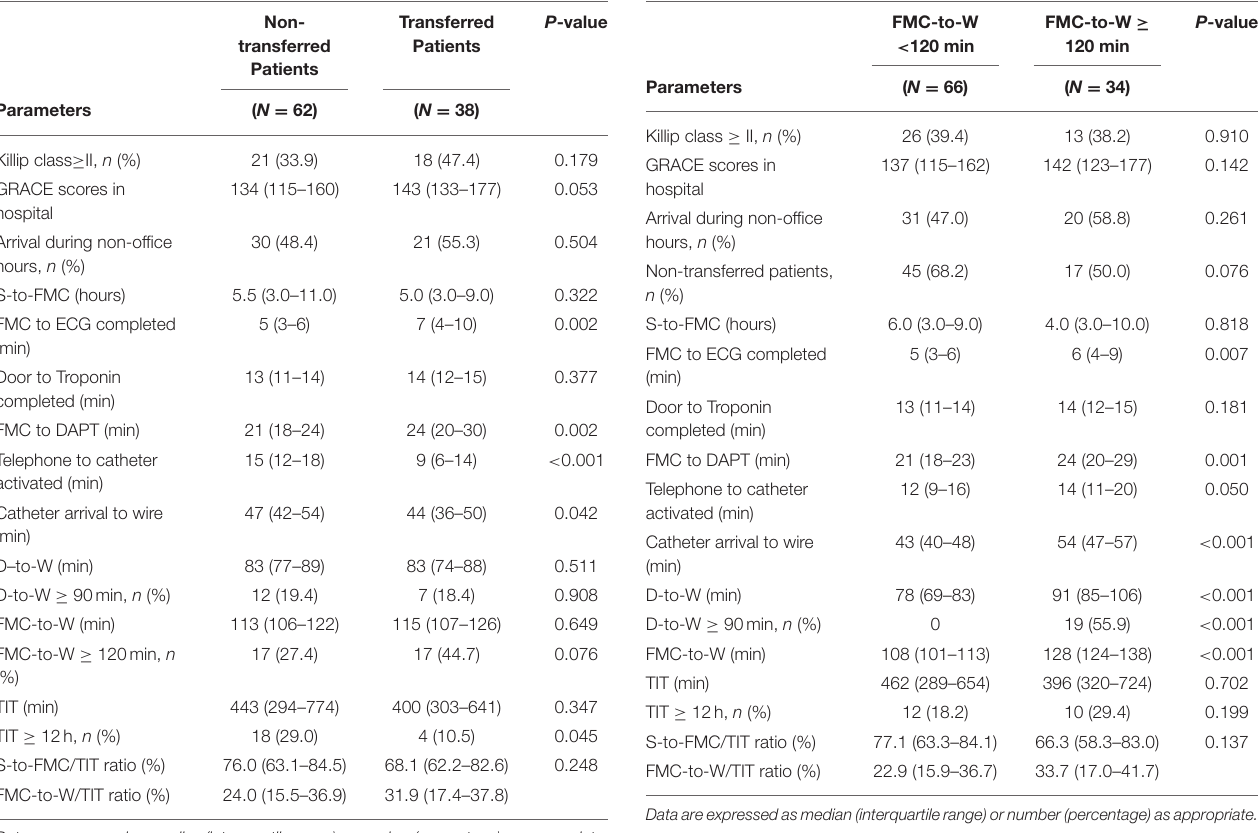
TABLE 3 | Comparison of PPCI parameters between different transferred methods during COVID-19 pandemic.